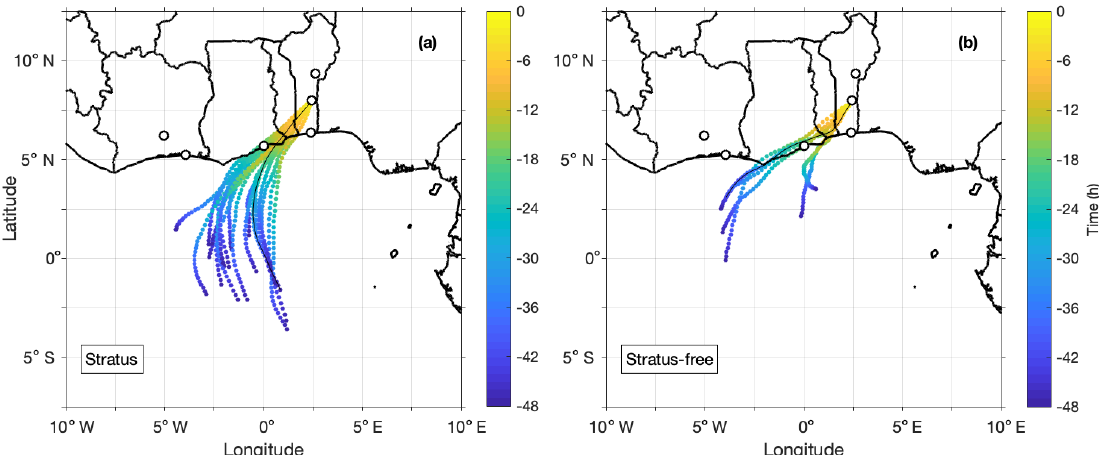
Figure 12. Geographical representation of the mean trajectories in the layer 30–50hPa above the surface for each stratus (a) and stratus-free night (b) from − 48 to 0h (color). Trajectories start at 03:00UTC. Black solid lines indicate the path of air parcels in IOPs 7 (a) and 10 (b)